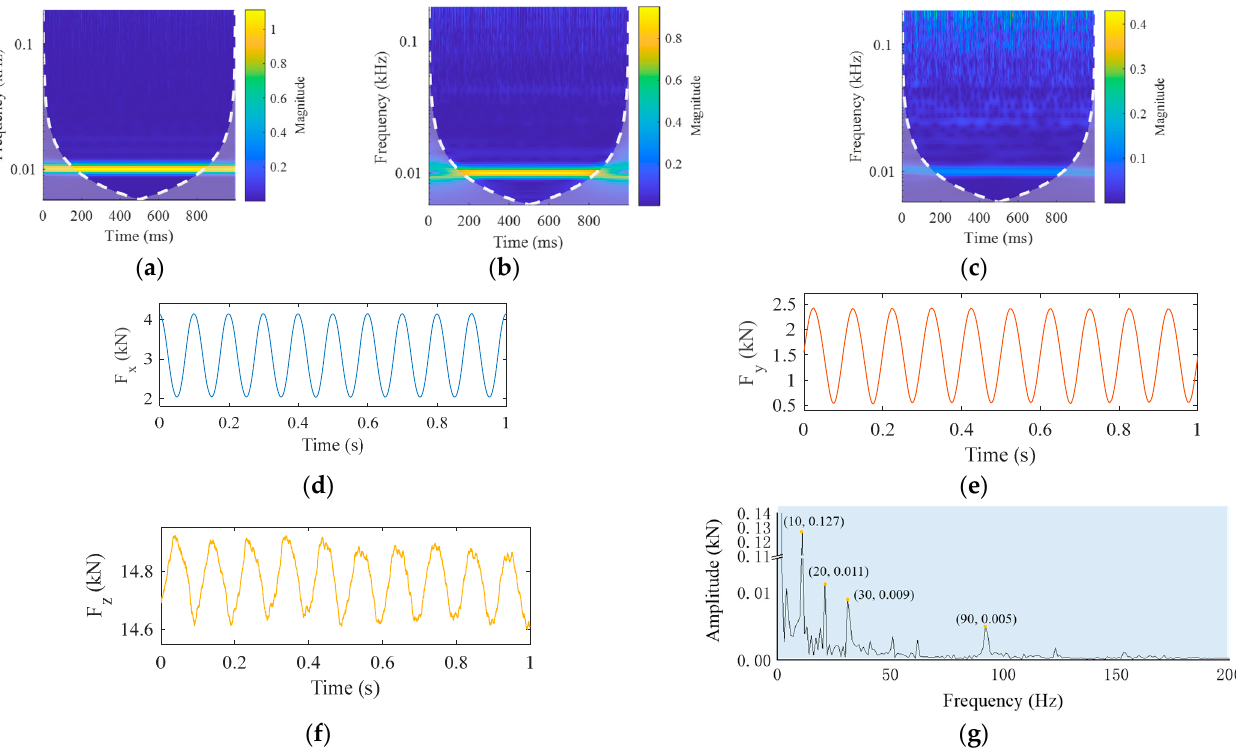
Figure 3. Time–frequency analysis and denoising of three-dimensional force data: ( a ) magnitude scalogram of Fx; ( b ) Fy; ( c ) Fz; ( d ) denoised Fx; ( e ) denoised Fy; ( f ) denoised Fz; ( g ) frequency spectrum of denoised Fz.